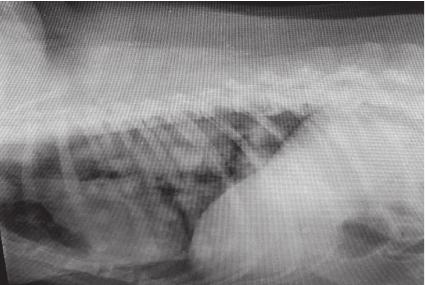
Figure 4: Lateral radiograph in a female Labrador revealed the presence of multiple nodular densities on the lung surface indic- ative of lung metastasis.